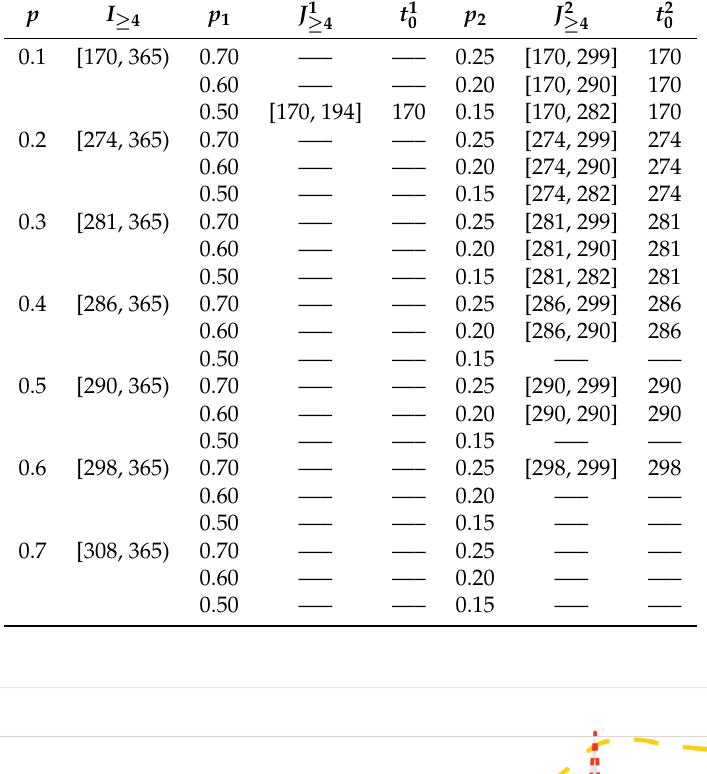
Table A1. Intervention instants t 0 versus the index p and the lower bound p 1 for effectiveness (Criterion 1) and the upper bound p 2 for the cost of intervention (Criterion 2) for m (cid:48) = 4. Grazing strategy UM.